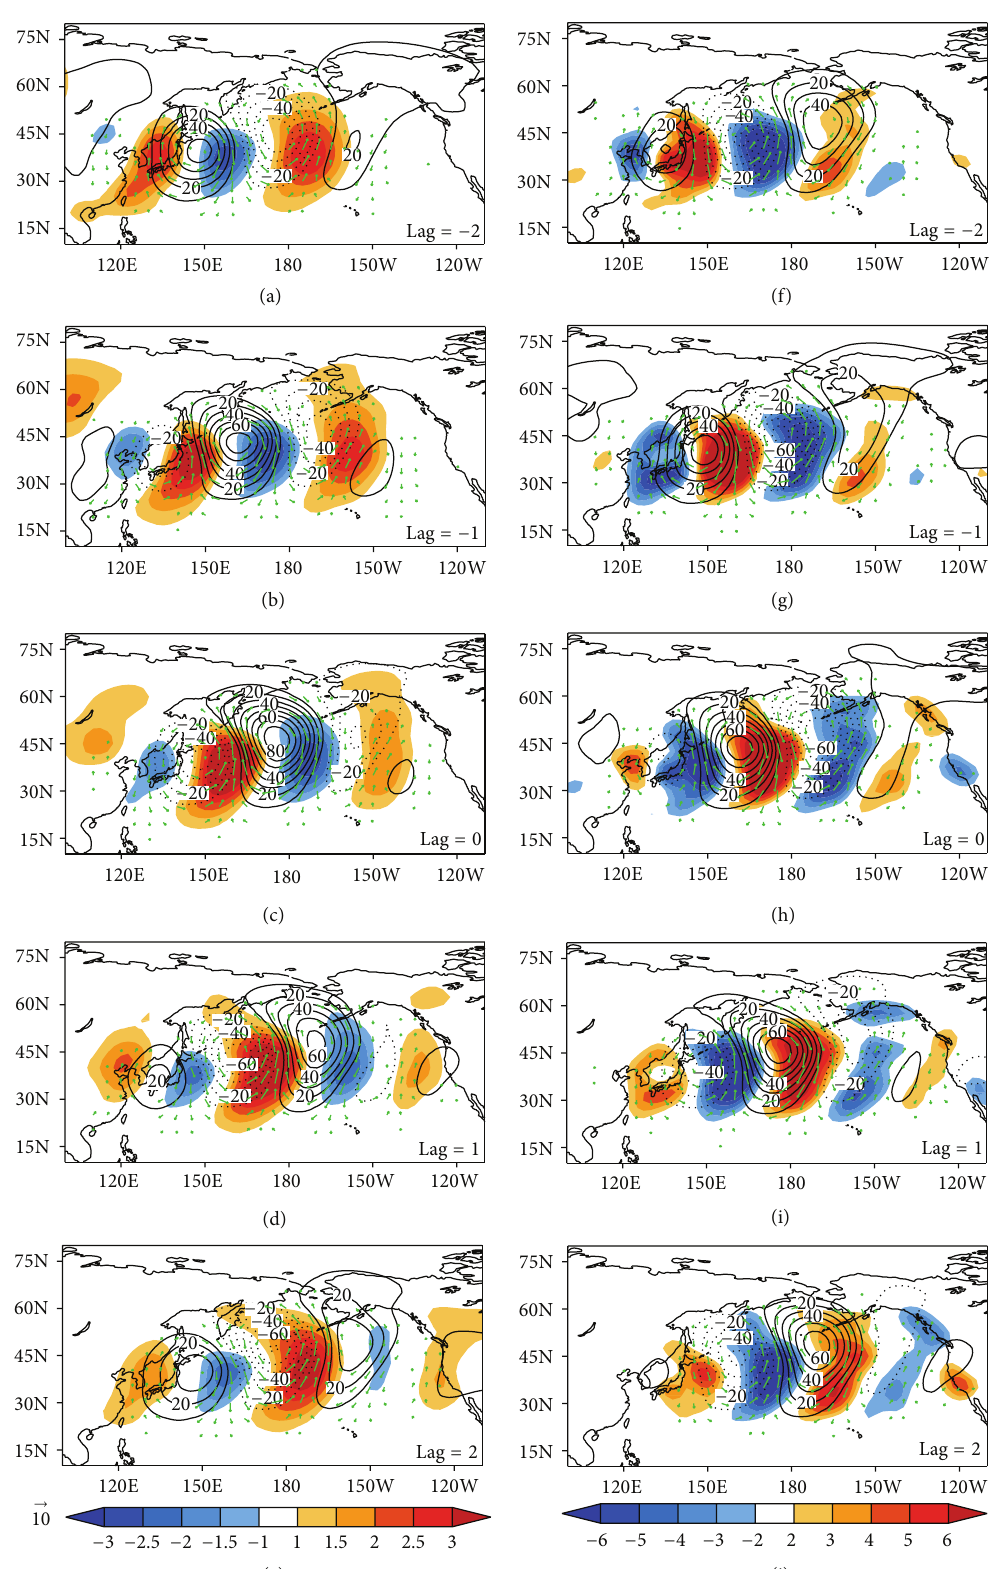
Figure3:Theheightperturbations(contour,unit:gpm),horizontalwindperturbations(vector,unit:m/s),temperatureperturbations(shaded in (a)–(e), unit: K), and vertical velocity perturbations (shaded in (f)–(j), unit: 10 −2 Pa/s) of the typical samples (PC1 > 2: (a)–(e); PC2 > 2: (f)–(j)), in which lag = − 2 corresponds to two days before the typical samples and so